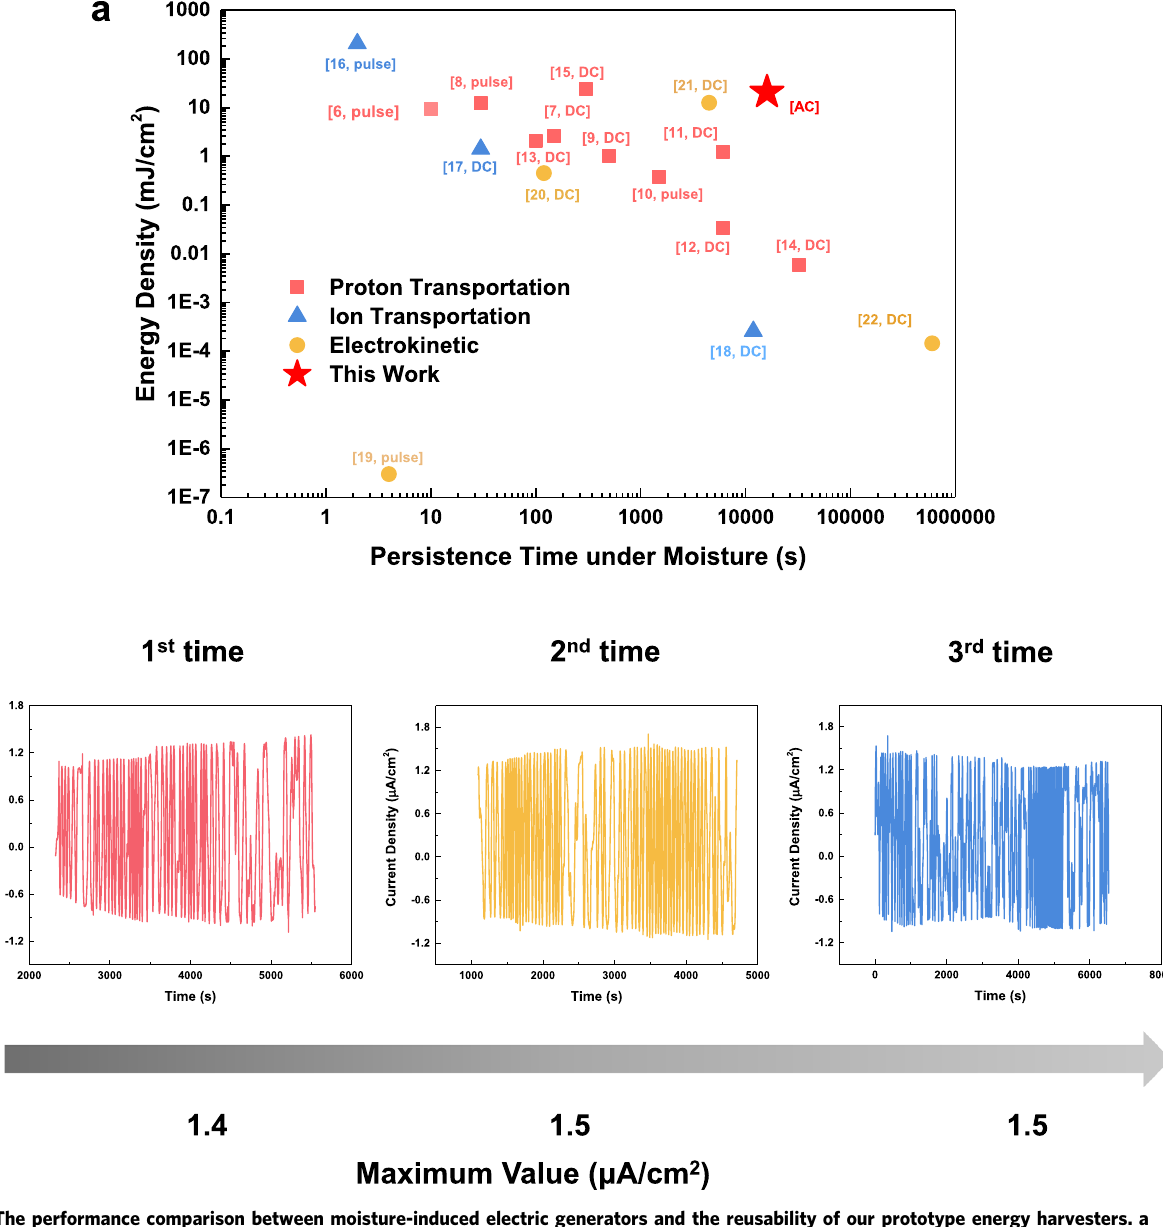
Fig. 5 The performance comparison between moisture-induced electric generators and the reusability of our prototype energy harvesters. a Comparing moisture-induced electric generators based on arti fi cial materials in the operation period and energy density. This work has a long persistence time and high-energy-density among moisture-based energy harvesters and these two parameters could be further improved by using other materials based on similar self-oscillation mechanisms. b The measured output current versus time results for a prototype energy harvester remains similar in three different independent tests in